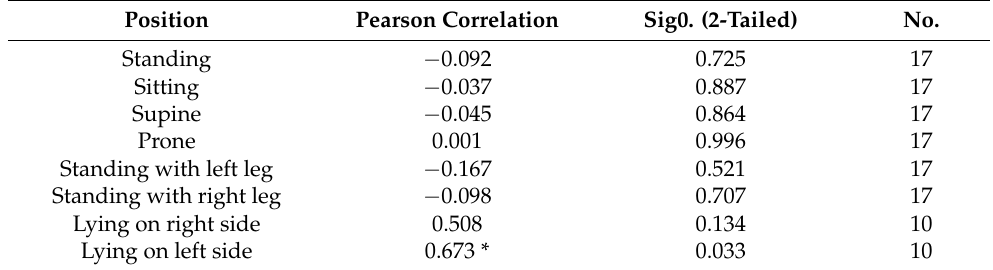
Table 4. Correlation between interface corrective force and discomfort level for all positions. Position Pearson Correlation Sig0. (2-Tailed)